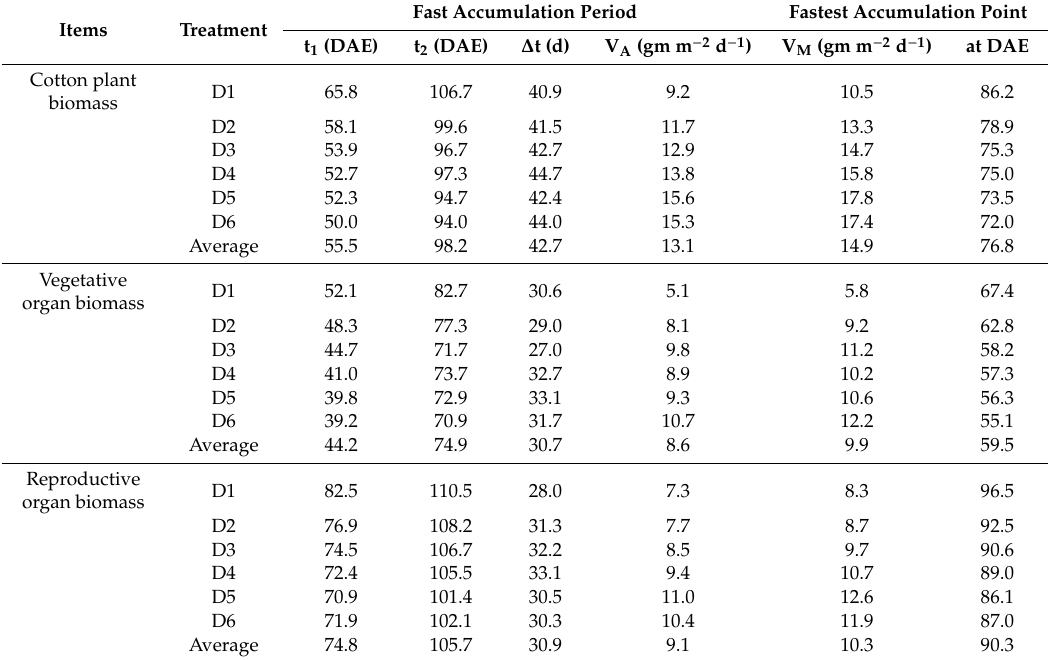
Table 6. Eigen values of cotton biomass accumulation at growing season